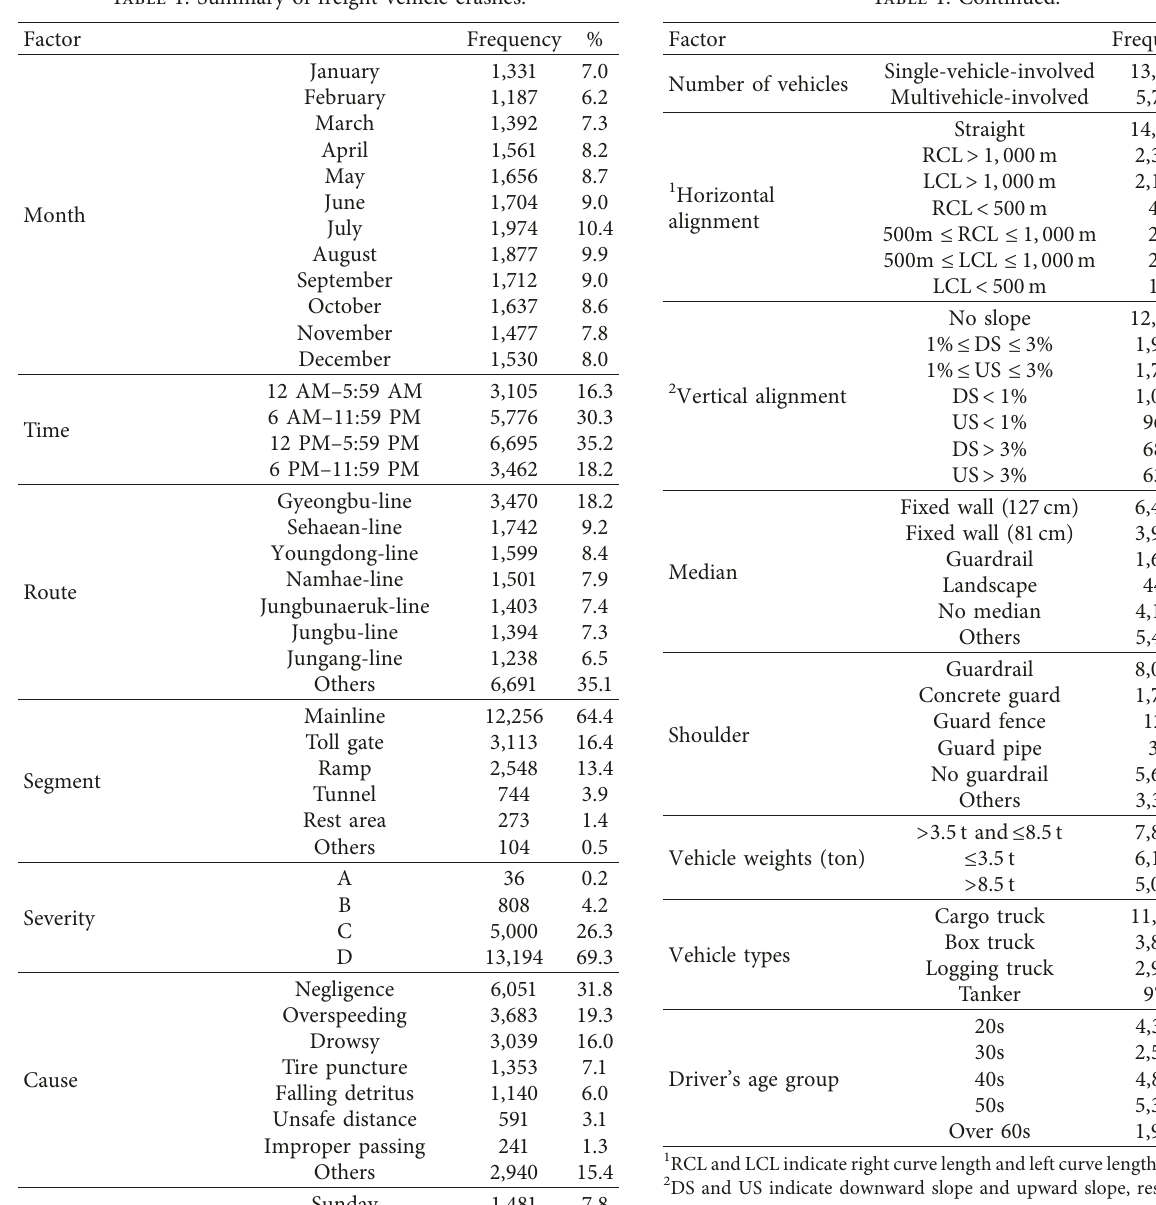
Table 1: Summary of freight-vehicle